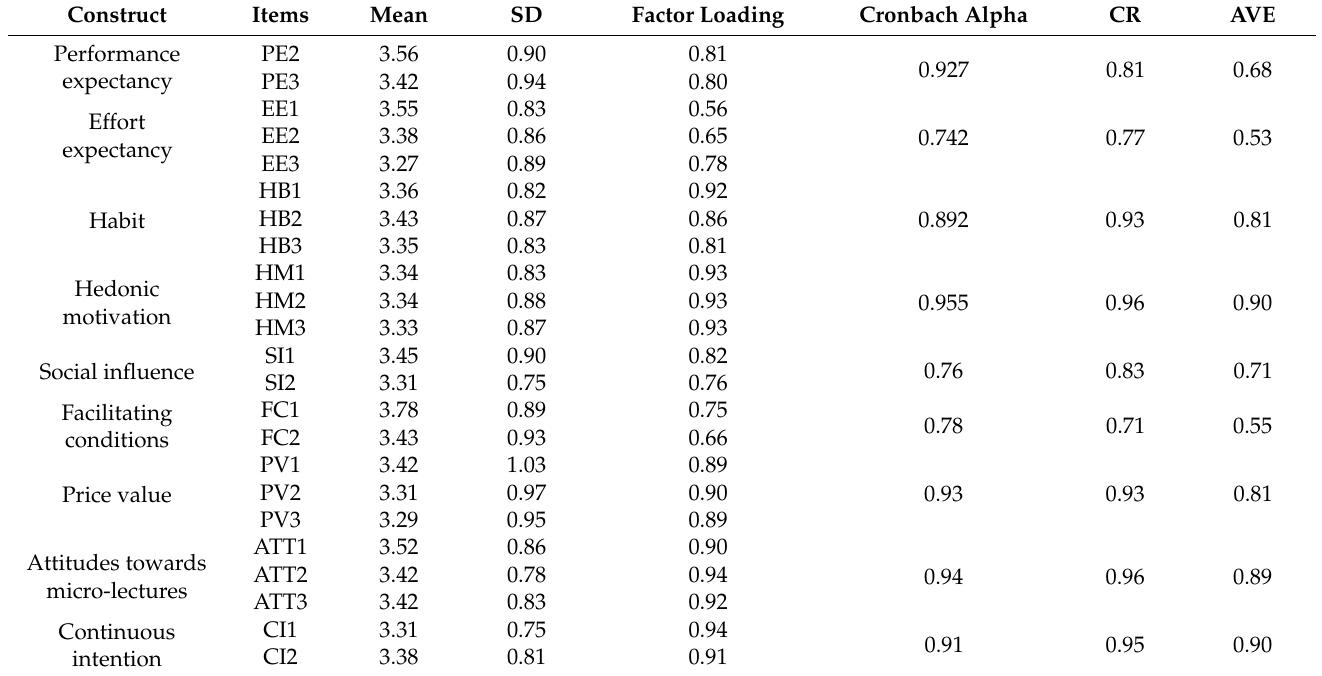
Table 3. The measurement construct validity ( n = 321).